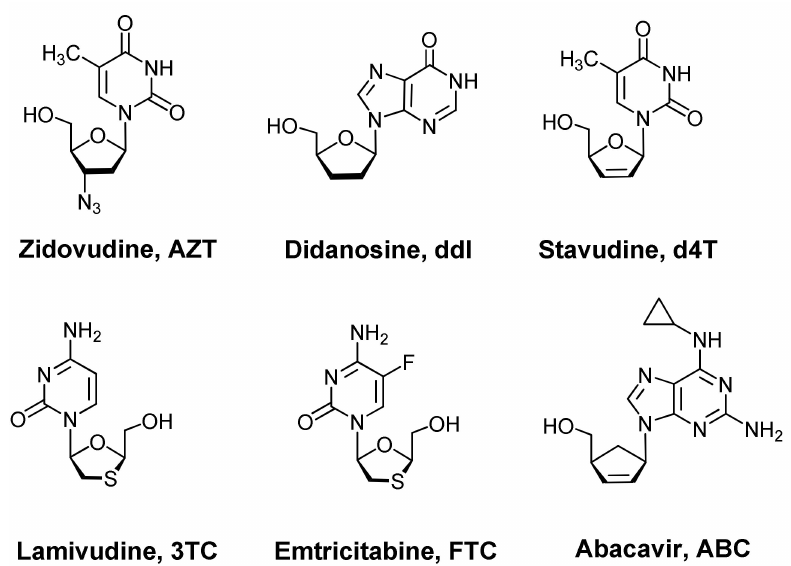
Figure 1. Example of nucleoside analogues—antiretroviral